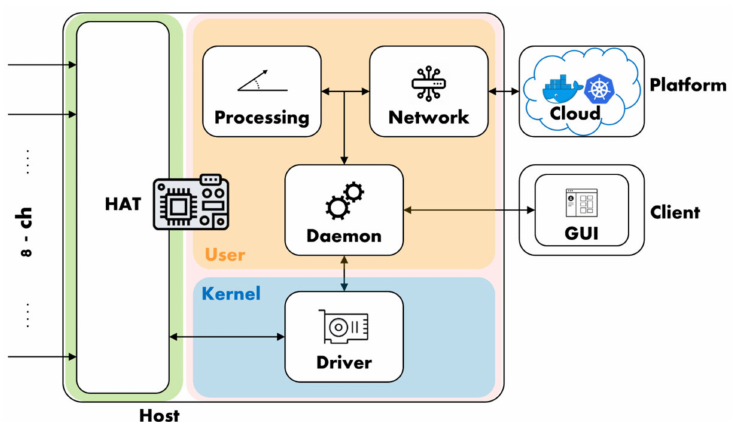
Figure 1. SMU architecture layers: hardware (green) and software (pink). The software layer is divided in kernel- (blue) and user-space